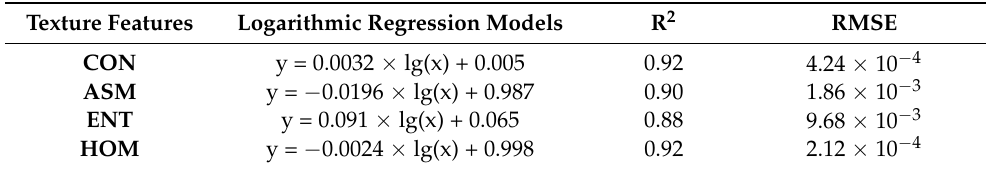
Table 5. Logarithmic regression models based on EC and texture features of soda saline–alkali soil samples with surface